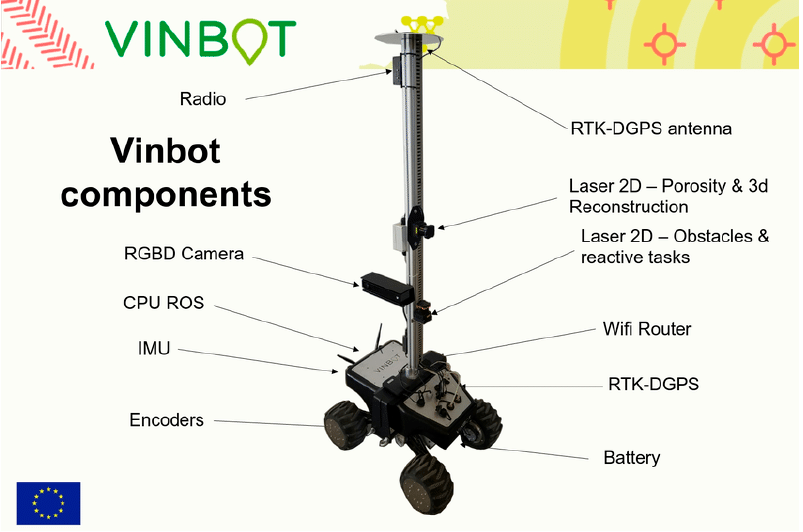
Figure 5. Sensors and components of the VINBOT Platform.